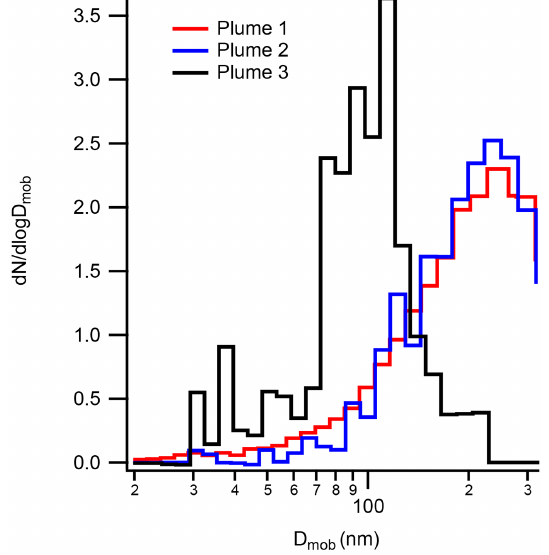
Figure 4. Average normalised bulk size distributions measured by the